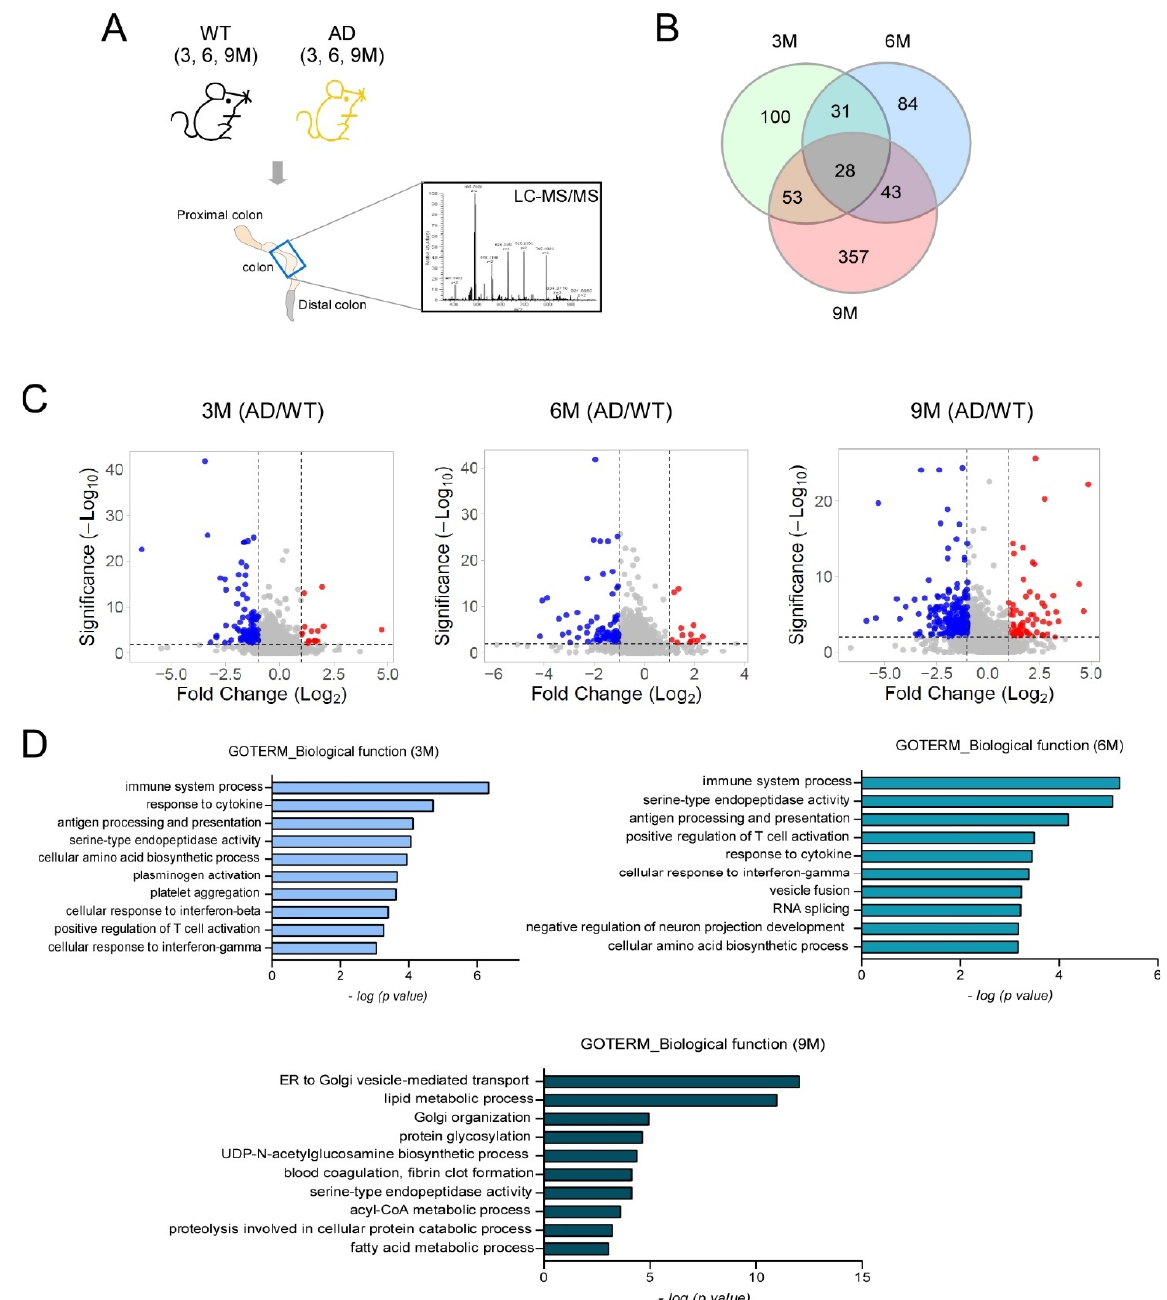
Figure 2. Colonic protein profiling alterations in AD mice over time. Colons were harvested from 5XFAD and WT mice at 3, 6, and 9 months and label free LC-MS/MS analyses were performed. ( A ) Proteomics analysis scheme. ( B ) The Venn diagram shows the proteins that were altered in 5XFAD colons over time (5XFAD/WT: 0.5 ≥ fold change ≥ 2). ( C ) Volcano plots represent significantly altered proteins (blue = down-regulated and red = up-regulated) in 5XFAD mice at 3, 6, and 9 months (5XFAD/WT: 0.5 ≥ fold change ≥ 2, unpaired t -test). ( D ) Gene Ontology biological process pathway analyses on altered proteins in 5XFAD mouse colons at 3, 6, and 9 months (Fischer’s exact test, p < 0.01). The top 10 pathways at each time point are shown.